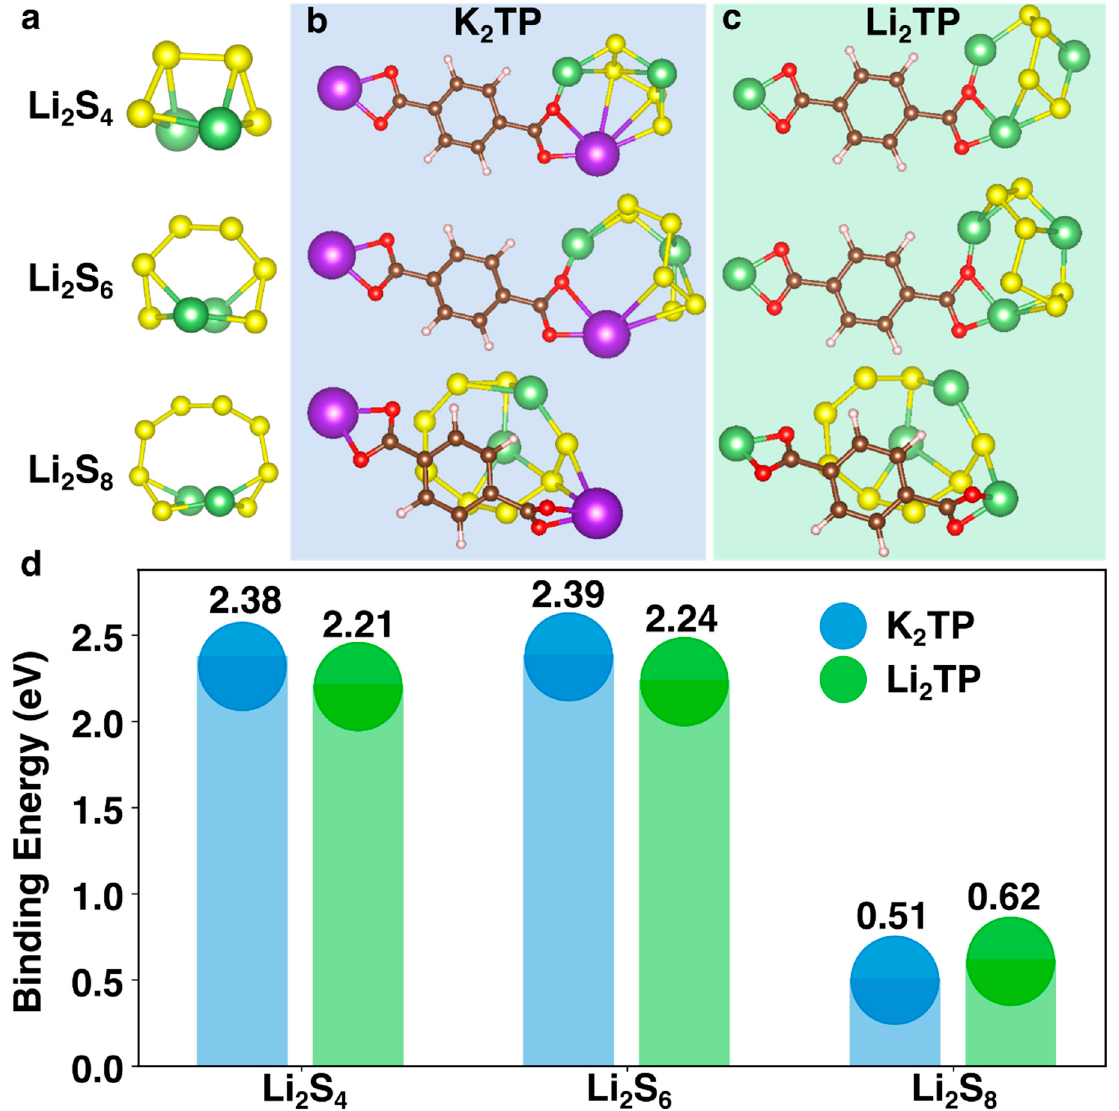
Figure 6. Binding energy between Li 2 TP and K 2 TP, and Li 2 S 4 , Li 2 S 6 , and Li 2 S 8 . ( a ) optimized geometry of Li 2 S 4 , Li 2 S 6 , and Li 2 S 8 ; binding configurations for ( b ) K 2 TP-LiPSs and ( c ) Li 2 TP-LiPSs; ( d ) summary of binding energy for each TPS-LiPS pair. The atoms were colored as: Li, green; K, purple; S, yellow; C, brown; O, red.